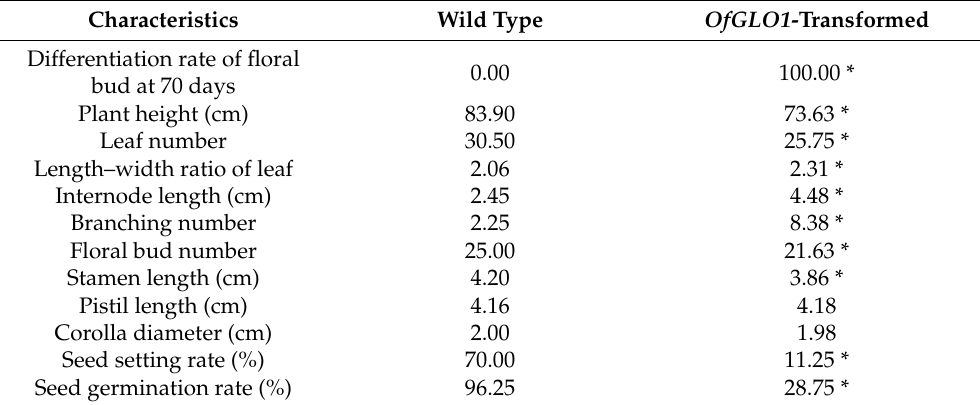
Table 1. Comparison of the characteristics between the OfGLO1 -transformed and wild-type plants. Characteristics Wild Type OfGLO1 -Transformed Differentiation rate of floral 0.00 100.00 bud at 70 days